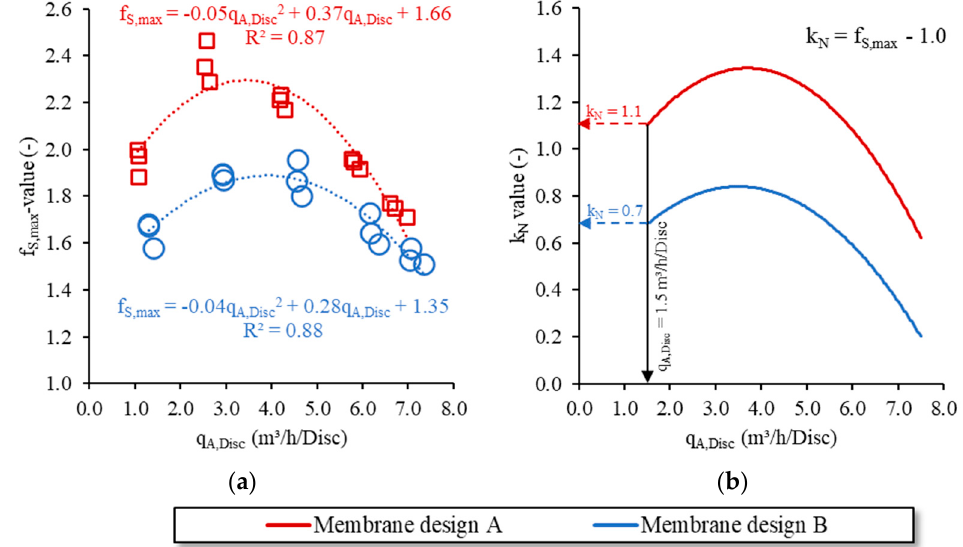
Figure 4. ( a ) f S,max measured in NaCl solution in a pilot-scale test tank for both membrane designs as a function of q A,Disc [2]; ( b ) k N calculated according to Equation (7) for both diffuser membrane designs as a function of q A,Disc ( b ).